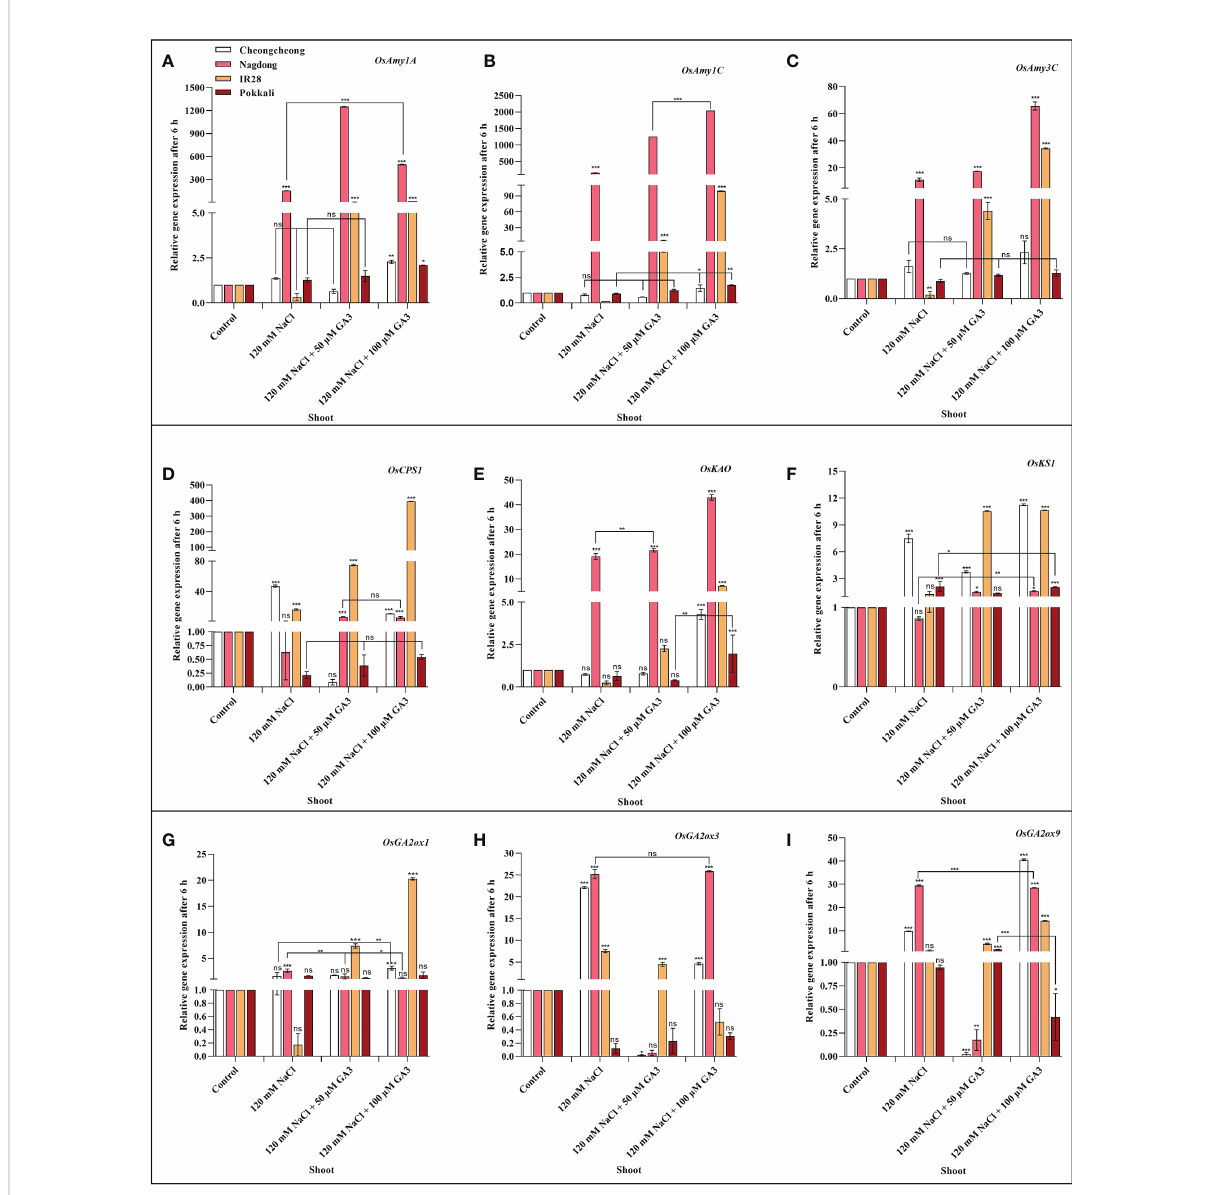
FIGURE 5 Effects of salt stress and exogenous GA 3 application on a -amylase and GA metabolic gene expression in the shoots of rice ( Oryza sativa L.) seedlings (A – I) . After 14-days incubation in distilled water, rice seedlings were treated with distilled water (control), 120 mM NaCl, or 120 mM NaCl + 50 or 100 µM GA3. After 6 h incubation, gene expression levels in the shoots of different rice cultivars were analysed. Data are presented as the mean ± SE, with gene expression levels given relative to the expression levels of a -amylase genes in the control group. Asterisks indicate a signi fi cant difference compared to control, analysed by Tukey ’ s multiple comparisons test. * P < 0.05, ** P < 0.01, *** P < 0.00; ns, not signi fi cant. GA, gibberellin; GA3, gibberellic